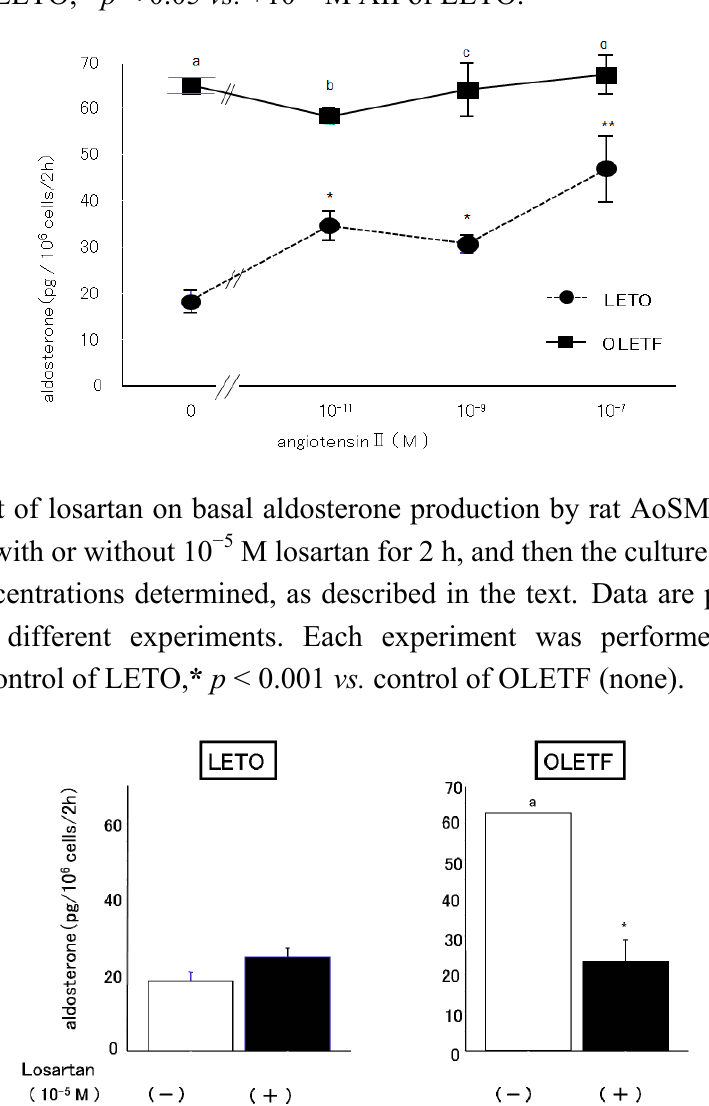
Figure 3. Effects of angiotensin II on aldosterone synthesis. The aldosterone production of rat AoSMC that had been cultured with or without angiotensin II for 2 h was determined as described in the text. The vertical bars represent the S.E.M. of the mean. * p < 0.01 vs. control (no additives); ** p < 0.001 vs. control (no additives). a p < 0.001 vs. control of LETO (no additives & +10 − 9 M AII ), b p < 0.01 vs. +10 − 11 M AII of LETO, c p < 0.001 vs.